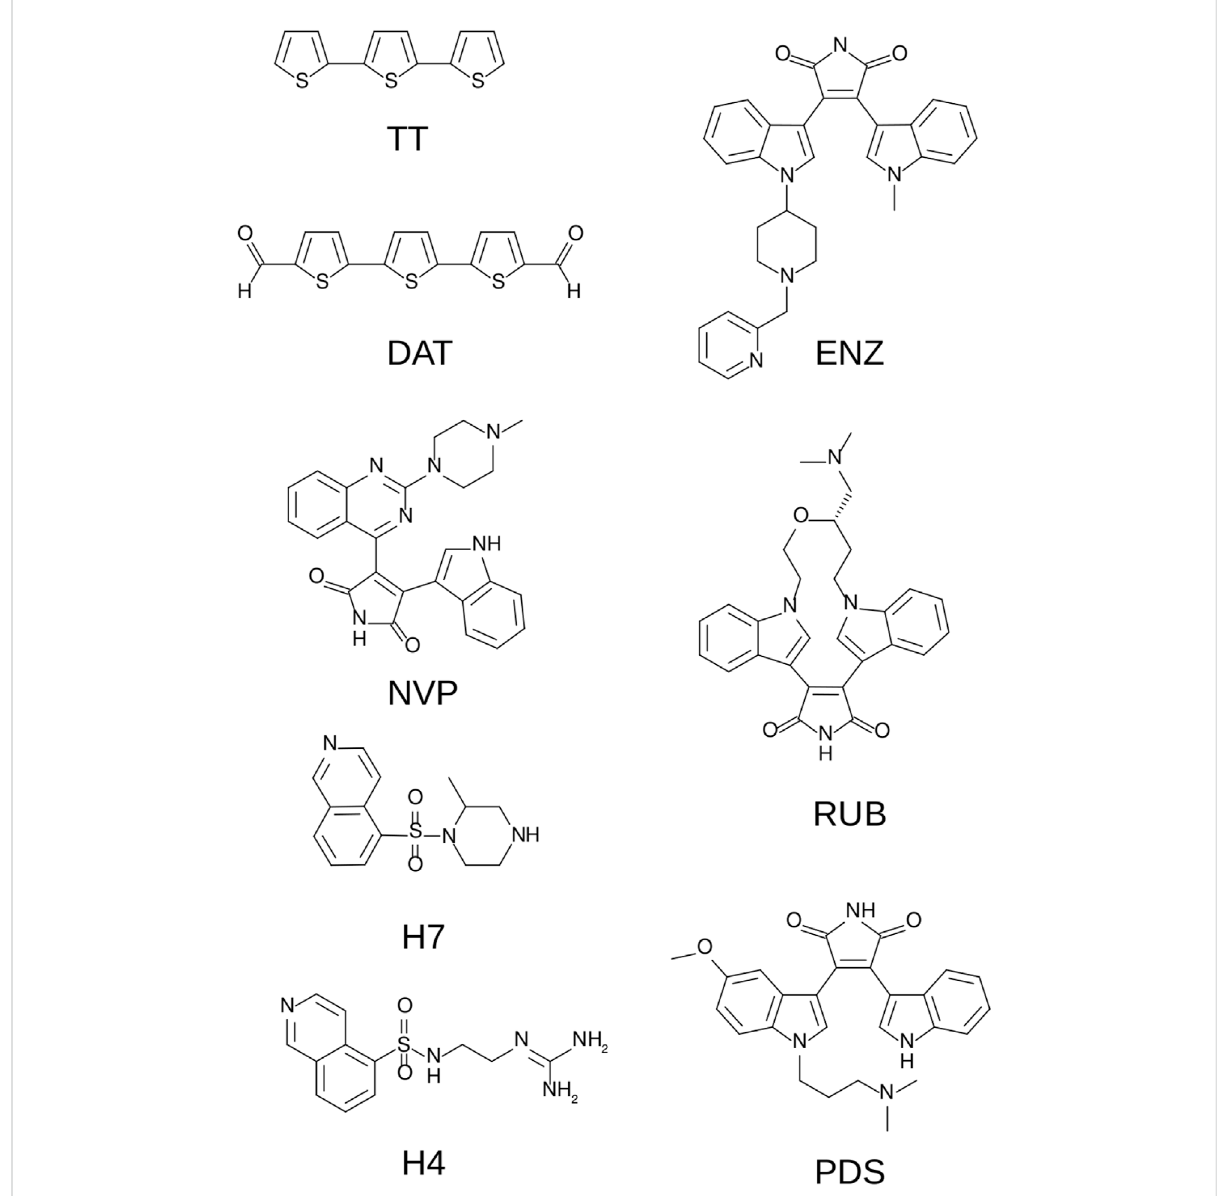
FIGURE 9 Comparison set for the different PKC ( α or β 2 isozymes)/inhibitor complexes. Includes terthiophene (TT), its dialdehyde derivative (DAT), enzastaurin (ENZ), NVP, ruboxistaurin (RUB), H7, H4 and PDS (see